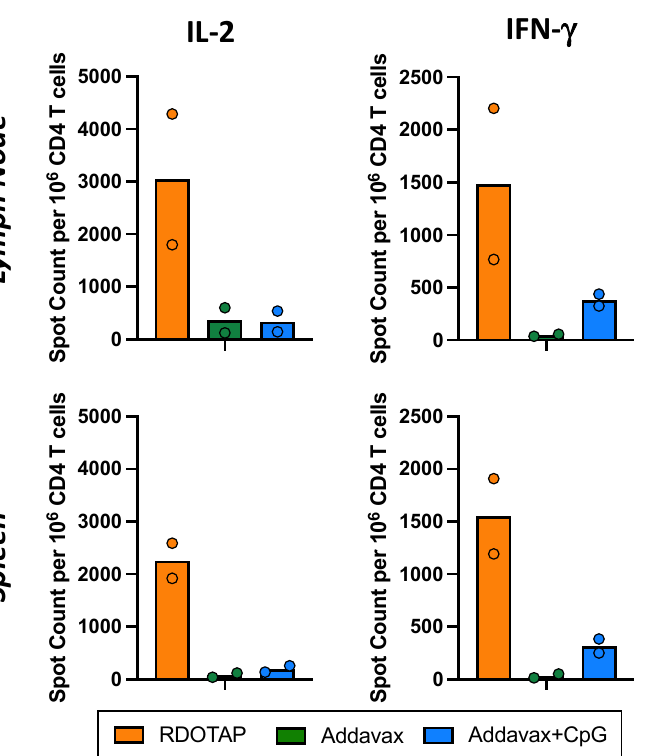
Figure 2. CD4 T cell response to influenza B HA following subcutaneous protein vaccination in three adjuvant systems, R-DOTAP (orange), AddaVax (green) and AddaVax + CpG (blue). CD4 T cells were isolated from the draining lymph nodes and spleen 10–11 days post vaccination and assayed for cytokine production using IL-2 ( left ) and IFN- γ ( right ) ELISpot assays. The frequency of cytokine-producing CD4 T cells in the draining lymph node ( top ) and spleen ( bottom ) in response to the HA-B peptides (summed) is shown. Background (APC + T cells with media) was subtracted from all responses. This is the average of two independent experiments with the individual experiments indicated as circles. Overall, 3–4 mice were pooled in each experiment.